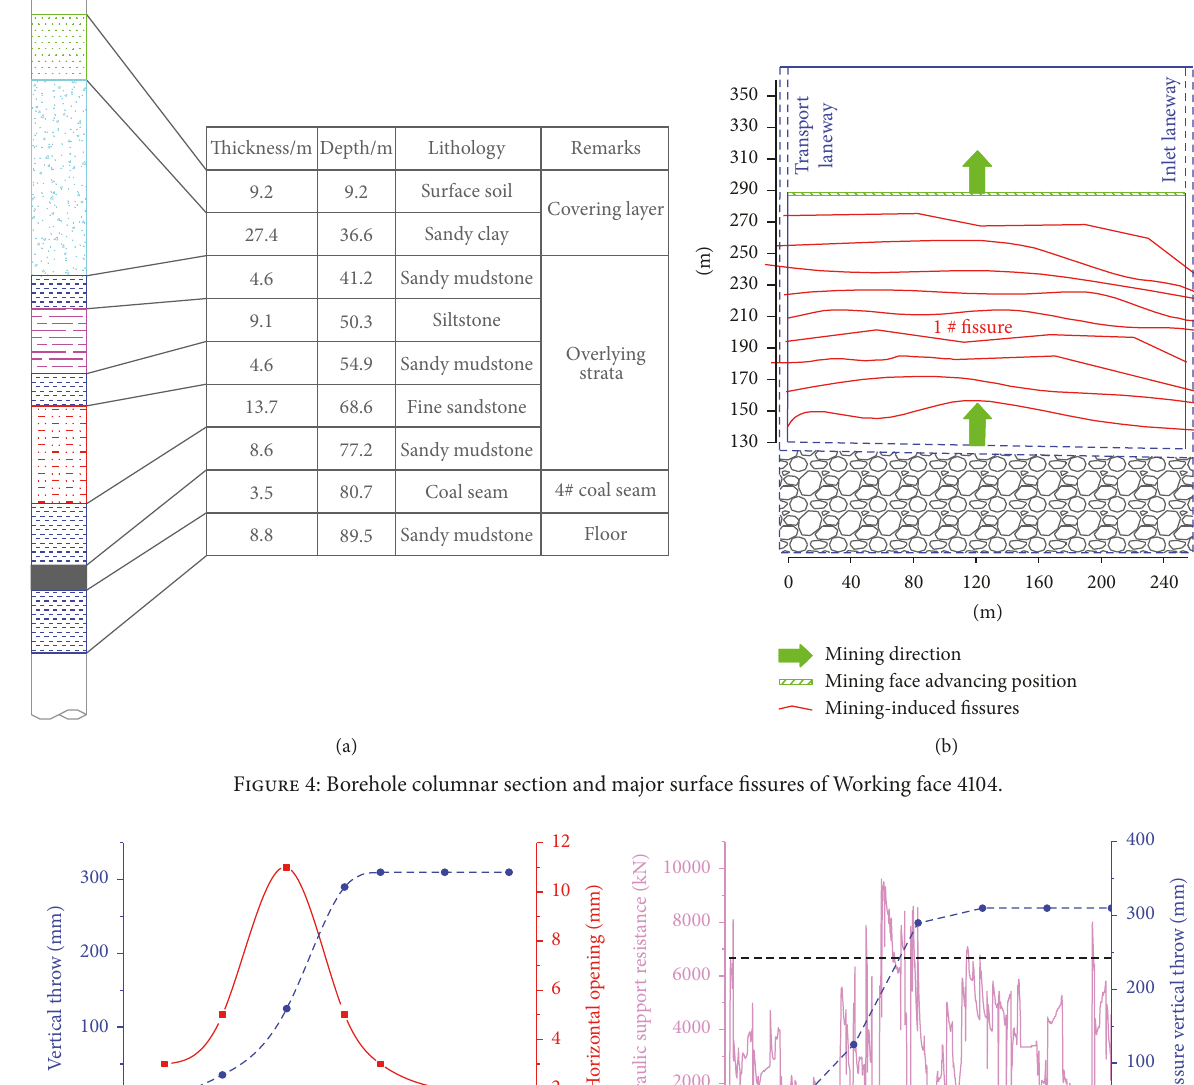
Figure 5: Dynamic development of mining-induced fissures in Working face